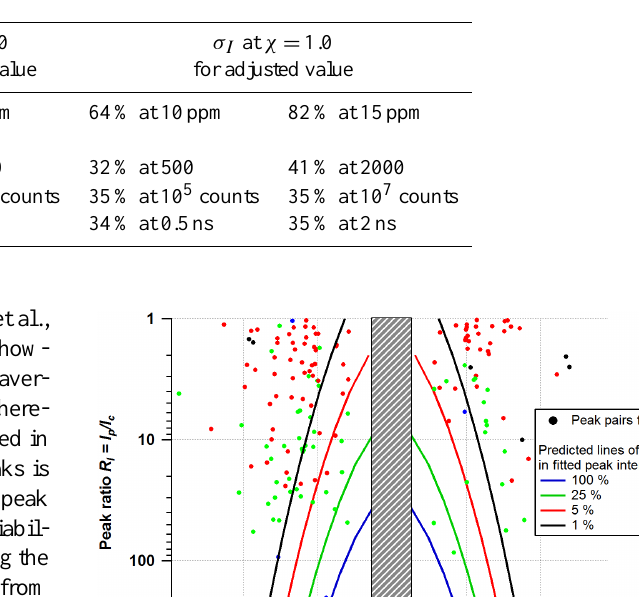
Table 1. Changes in precision in fitted intensity of the child peak when altering properties of the fitting procedure and its input distributions, whilst holding the peak intensity ratio constant at 2.